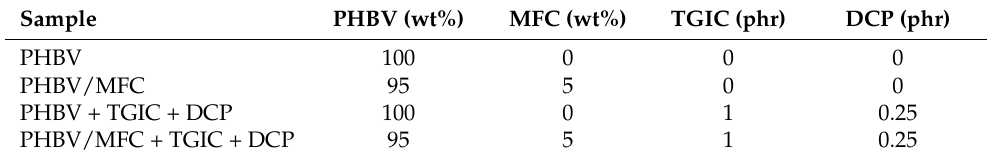
Summary of film compositions according to the weight content (wt%) of poly(3- hydroxybutyrate- co -3-hydroxyvalerate) (PHBV) and microfibrillated cellulose (MFC) in which trigly- cidyl isocyanurate (TGIC) and dicumyl peroxide (DCP) were added as parts per hundred resins (phr) of green